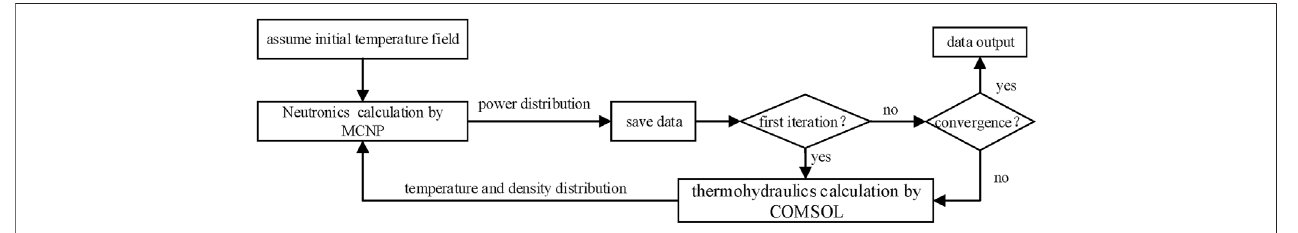
FIGURE 6 | Flowchart of the coupling procedure.